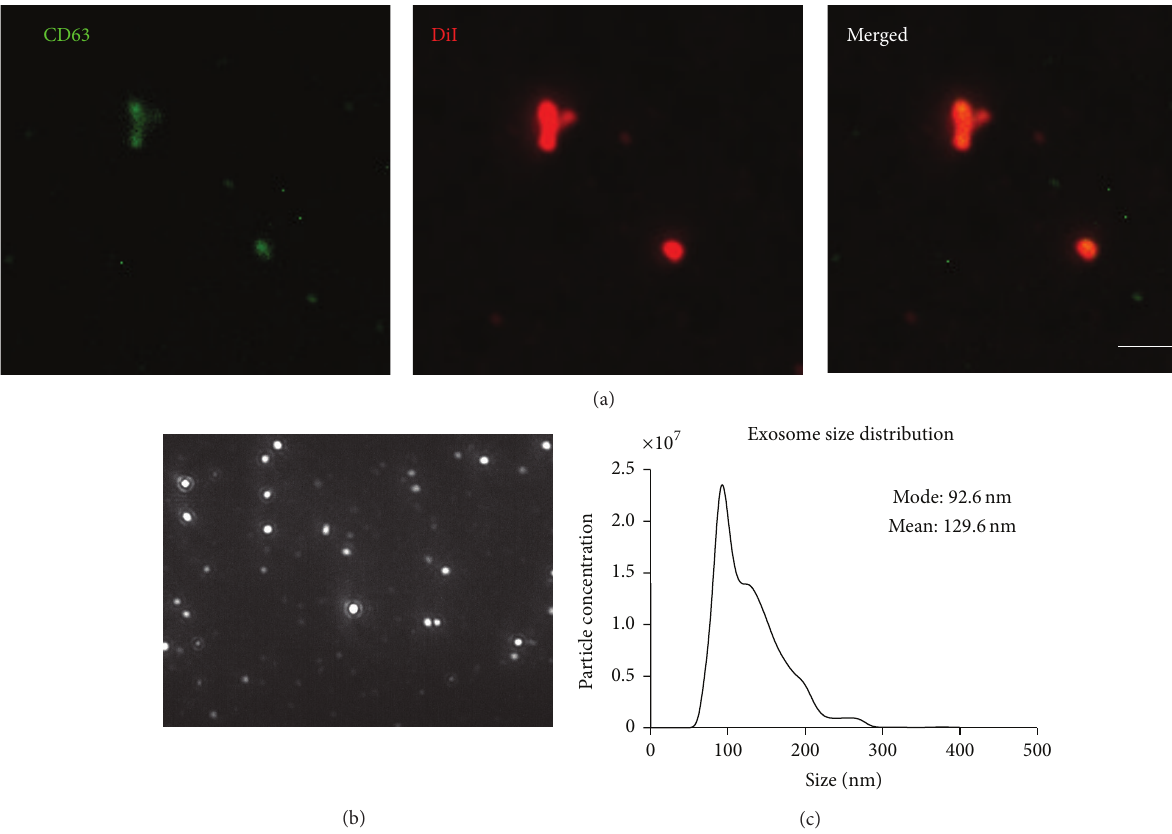
Figure 2: Characterization of exosomes using (a) immunofluorescence indicates the CSC-XOs are positive for CD63, an exosomal marker. Scale = 5 𝜇 m. (b) NanoSight particle tracking image; (c) size distribution as reported by NTA shows that the exosomes are within the expected size range verifying there are no other extracellular vesicles present.